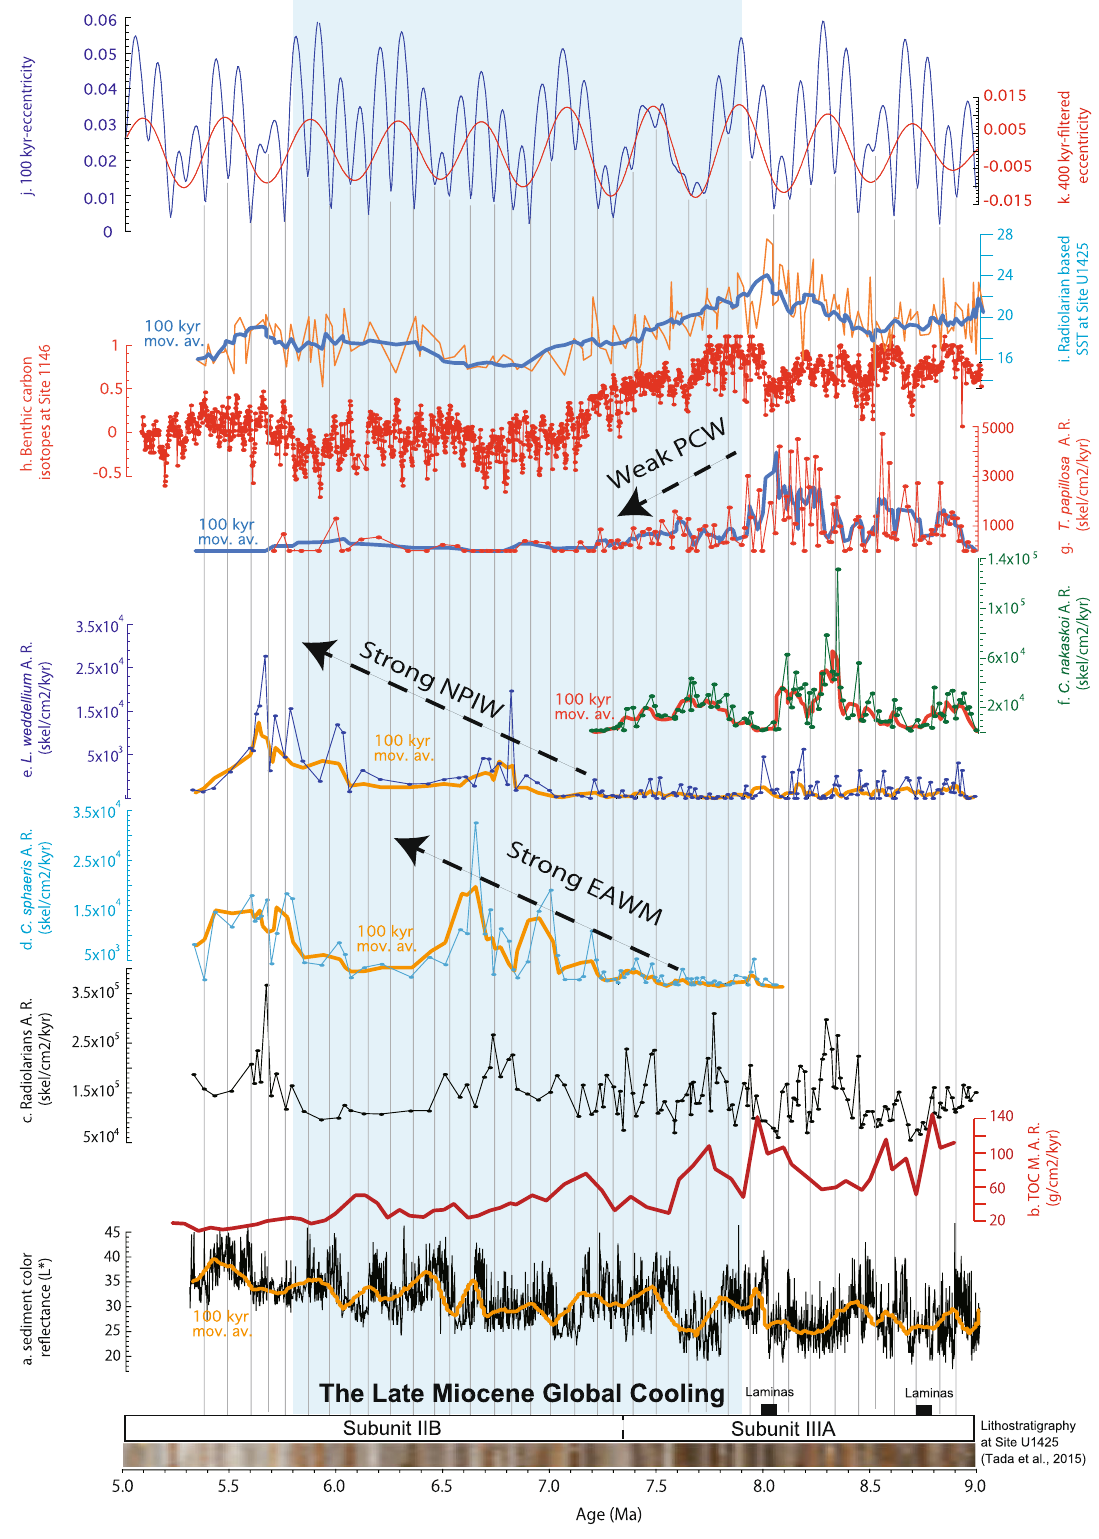
Figure 2. Paleoceanographic evolution of the Japan Sea across the late Miocene global cooling (LMGC). In the (X) axis, the age memory with lithological subunits at site U1425 and their lithologies 33 : ( a ) Sediment color lightness (L*) at site U1425 33 and ( b ) mass accumulation rates (g. cm −2 . ky −1 ) of the total organic carbon (TOC) accumulated on the seafloor at IODP site U1425 22 with age updated model 24 . Fluxes (accumulation rates in units of skel −1 .cm −2 . ky −1 ) of ( c ) the total radiolarians (black), ( d ) Cycladophora sphaeris (light blue), ( e ) L. weddellium (dark blue), ( f ) Cycladophora nakasekoi (green), and ( g ) T. papillosa (red), all in this study. ( h ) Benthic carbon isotope stratigraphy at ODP 1146, South China Sea 3 , ( i ) radiolarian-based winter-time sea surface temperature in the Japan Sea at site U1425 36 , ( j ) 100 ky eccentricity cycle (63), and ( k ) 400 ky filtered eccentricity cycle 63 . Hairlines indicate projections of the eccentricity minima. The graphs were generated using KaleidaGraph software version 4.5 (https:// www. syner gy.